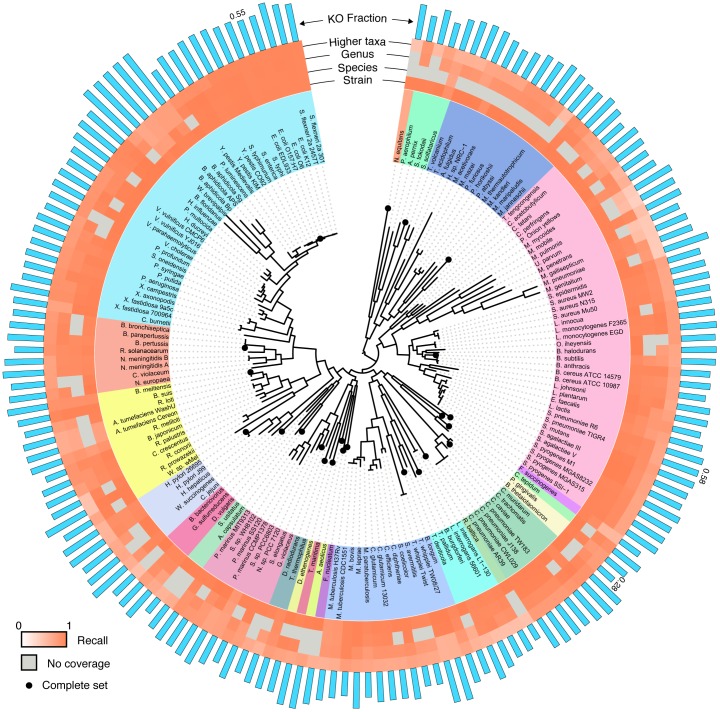
The performance of BLAST-based annotation of short reads across the bacterial and archaeal tree of life.The phylogenetic tree was obtained from Ref. [50]. Colored rings represent the recall for identifying reads originating from a KO gene using the top gene protocol. The 4 rings correspond to varying levels of database coverage. Specifically, the innermost ring illustrates the recall obtained when the strain from which the reads originated is included in the database, while the other 3 rings, respectively, correspond to cases where only genomes from the same species, genus, or more remote taxonomic relationships are present in the database. Entries where no data were available (for example, when the strain from which the reads originated was the only member of its species) are shaded gray. For one genome in each phylum, denoted by a black dot at the branch tip, every possible 101-bp read was generated for this analysis. For the remaining genomes, every 10th possible read was used. Blue bars represent the fraction of the genome's peptide genes associated with a KO; for reference, the values are shown for E. coli, B. thetaiotaomicron, and S. pneumoniae.